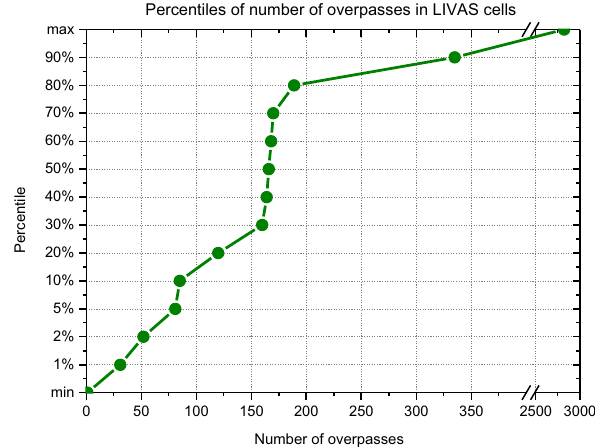
Figure 14. Percentiles of the number of overpasses in LIVAS global grid